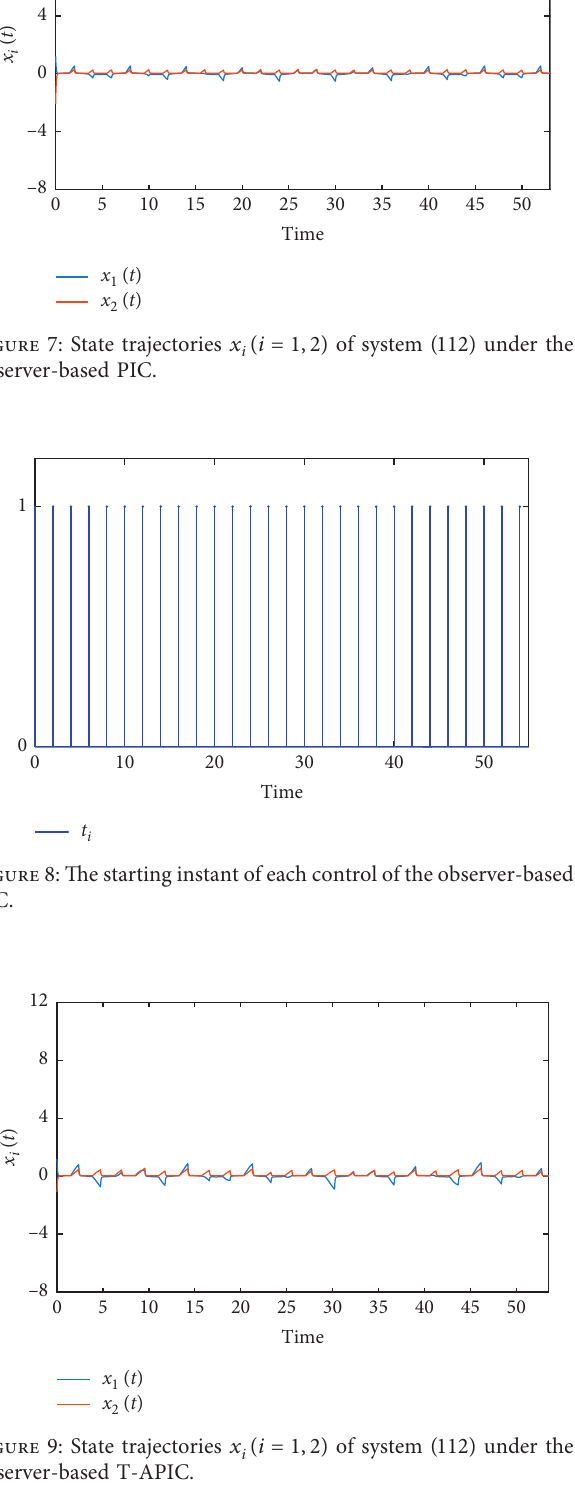
( i � 1 , 2 ) of system (112) under the i